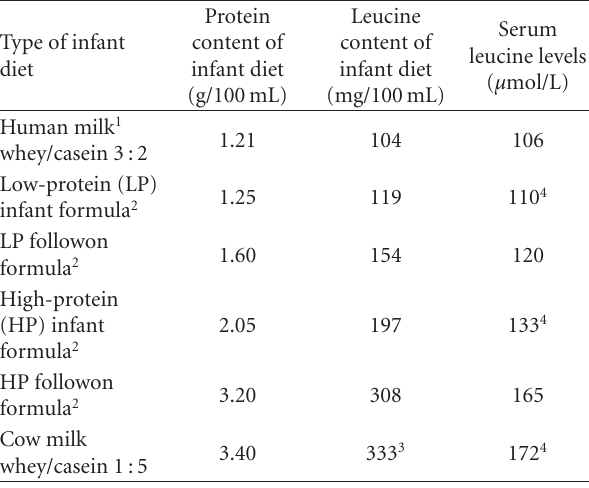
Table 3: Leucine content of infant diet and serum leucine